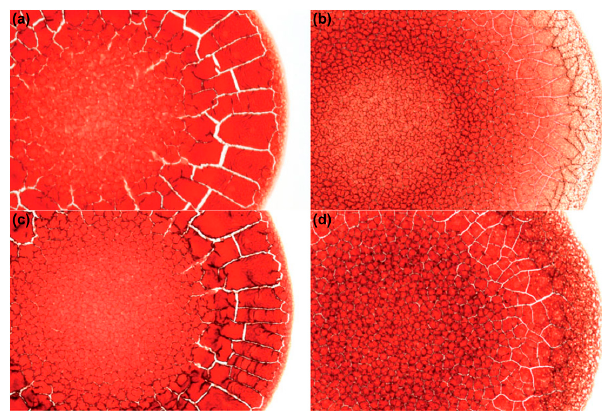
Figure 3. Blood samples dried on a glass surface from: ( a ) 27-year-old healthy woman; ( b ) a person with anemia; ( c ) a 31-year-old healthy man; ( d ) a person with hyperlipidemia. Adapted with permission from [30] (p. 90). Copyright 2011 Cambridge University Press.